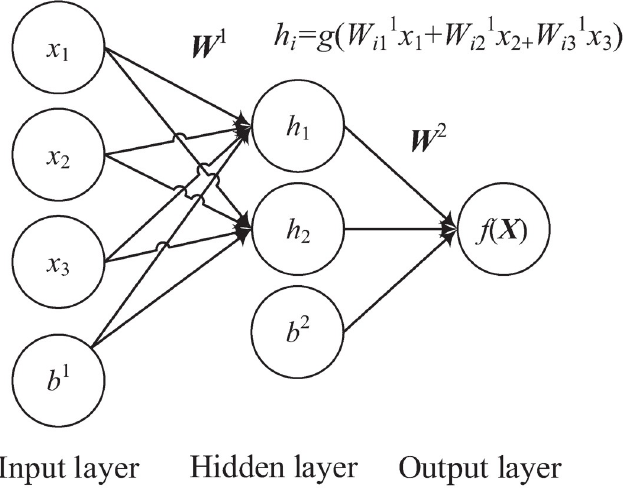
Fig 4. An example of MLP with three input neurons, two hidden neurons, and one output neuron.